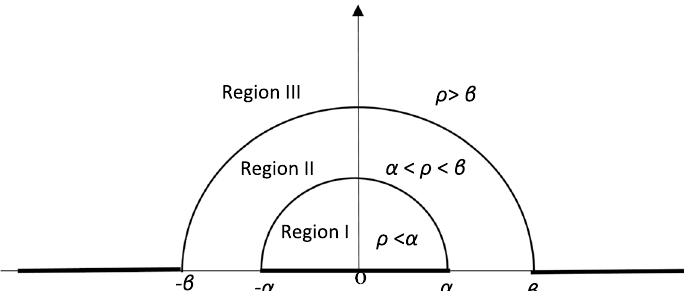
Fig. 3 Split regions in the upper